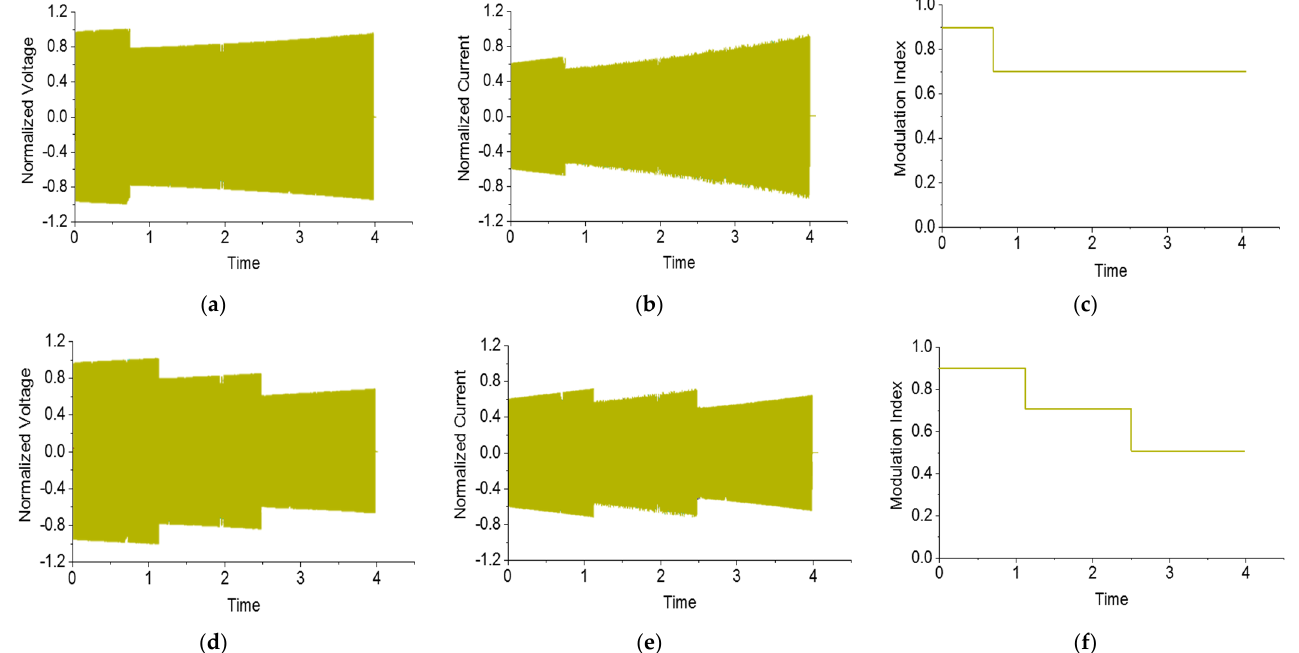
Figure 10. The output voltage and current limitation with the IVCC in the simulated load: ( a ) the normalized output voltage in the instant voltage control operation; ( b ) the normalized output current in the instant voltage control operation; ( c ) the modulation index with the IVCC in the instant voltage control operation; ( d ) the normalized output voltage in the instant current control operation; ( e ) the normalized output current in the instant current control operation; ( f ) the modulation index with the IVCC in the instant current control operation.